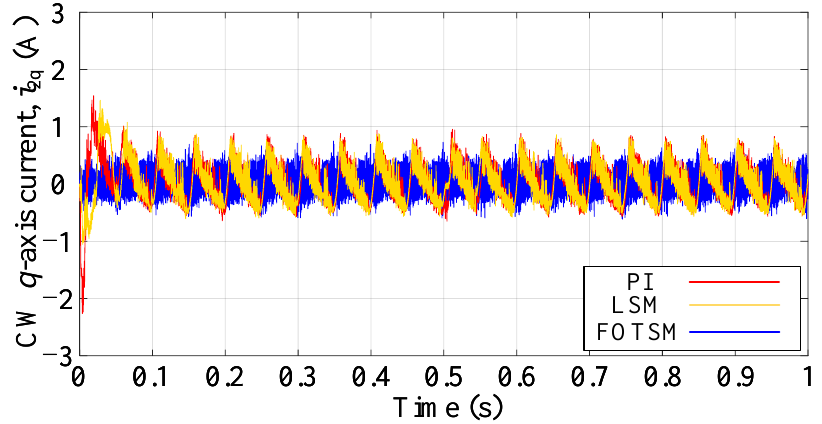
Figure 13. The CW q -axis current responses under PI, LSM, and FOTSM during the voltage change process.